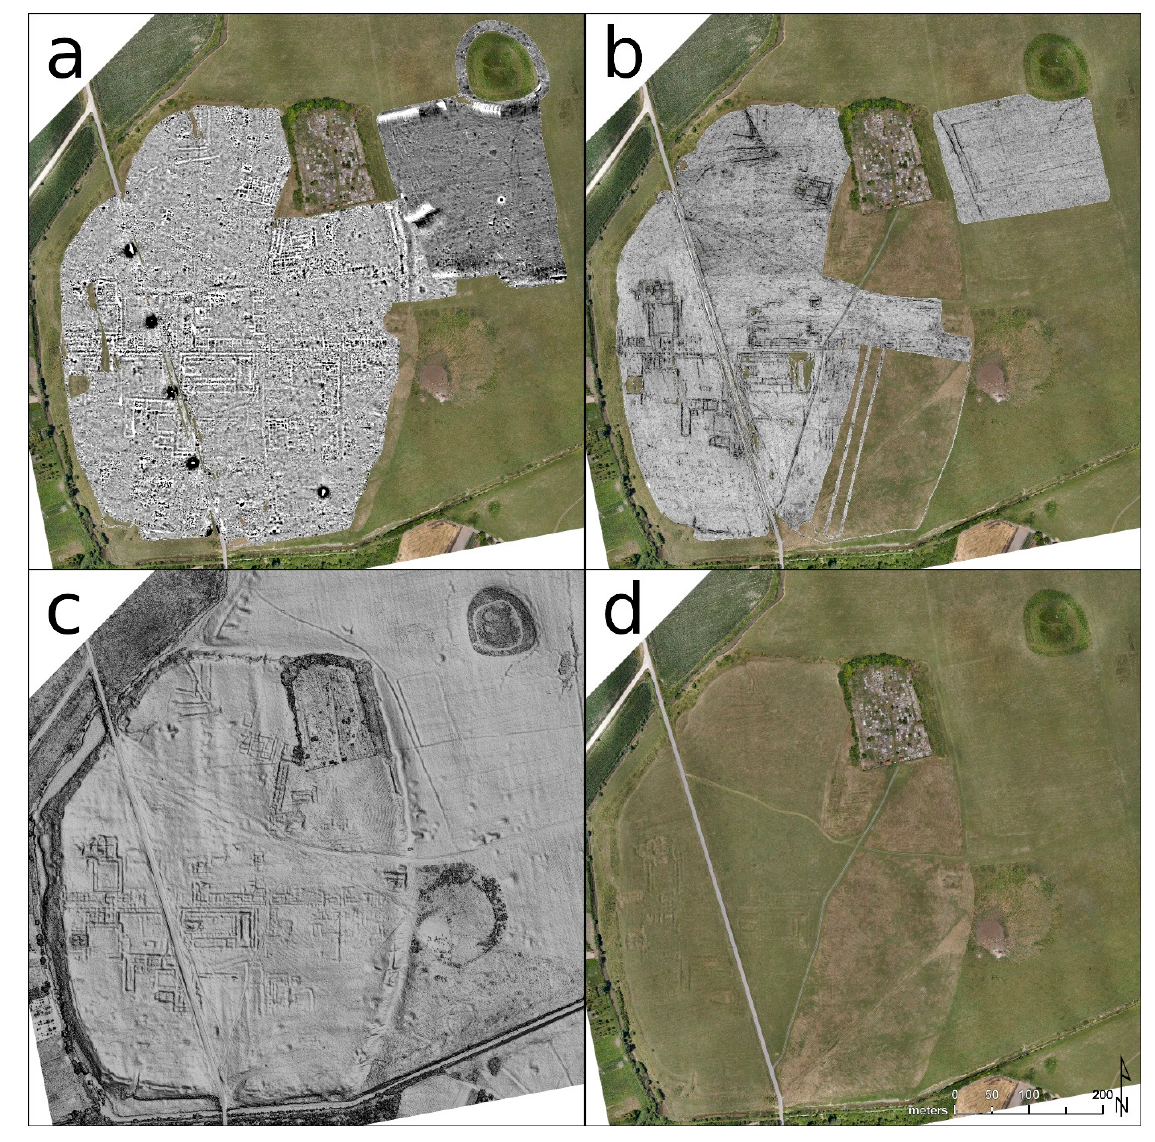
Figure 10. Archaeological prospection data of the central area at Bassianae . ( a ) Magnetic data image with greyscale values of -6 nT (white) and +6 nT (black); ( b ) GPR depth-slice from approximately 1.0 to 1.2 m depth; ( c ) multidirectional hillshade of the DSM with 3 × Z exaggeration; ( d ) orthophotomosaic of all UAS images. In contrast to the 1935 aerial photo depicted in Figure 3a, the orthophotograph shown in ( d ) does not reveal all surface undulations. These are only visible from the air through the proxy of shadow marks. However, the 2014 aerial sorties were not solely flown during low-slanting sunlight conditions (as those of Figure 4) because the DSM offers many ways to visualize these topographic differences.